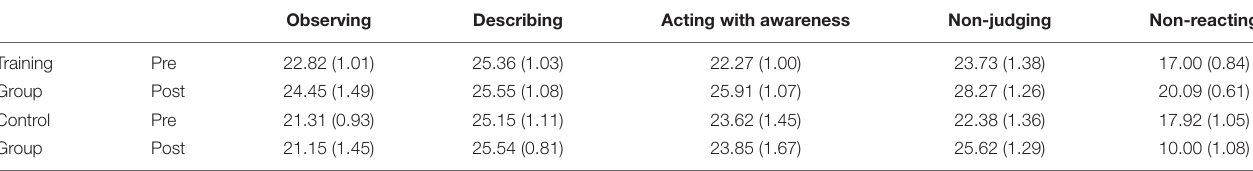
Observing Describing Acting with awareness Non-judging